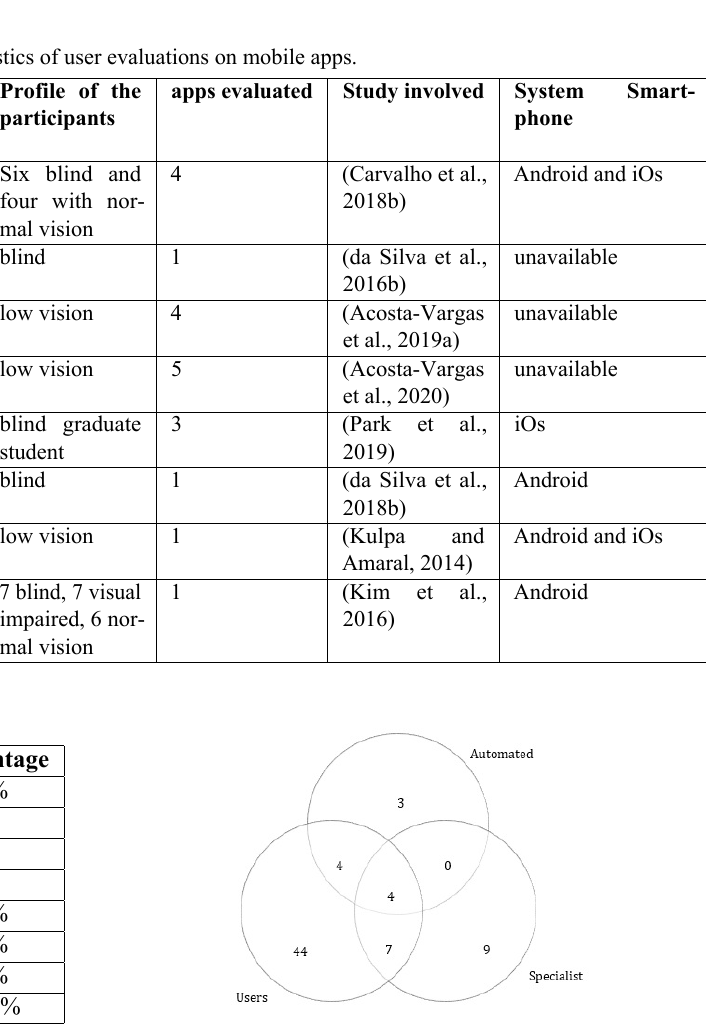
Figure 2. Distribution of coverage of problems on the mobile